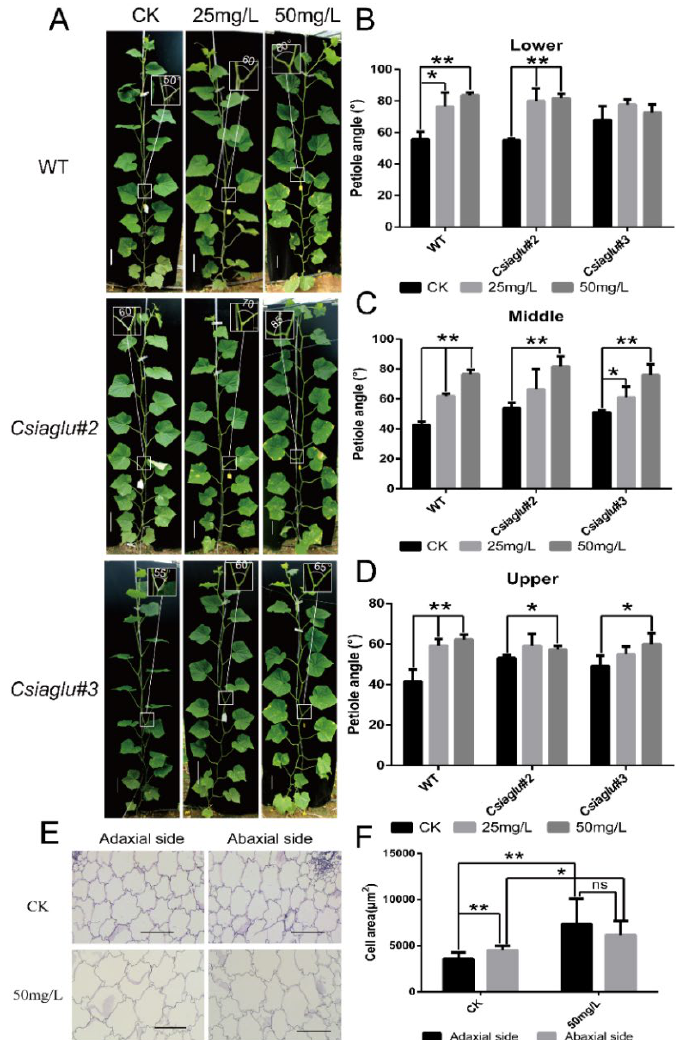
Figure 5. IAA treatment resulted in increased LPA in cucumber: ( A ) Representative images of WT and Csiaglu mutant plants following auxin application. The white boxes indicate the LPA of the largest leaf. Scale bars represent 10 cm. ( B - D ) Statistical analysis of LPAs of WT and Csiaglu mutants: lower LPAs ( B ), middle LPAs ( C ) and upper LPAs ( D ). Values are means of LPAs from the same part of three independent plants. ( E ) Cell morphology of transverse section of petiole base in CK plants and plants treated with 50 mg/L IAA. Scale bar = 100 µ m. ( F ) Cell area statistics of petiole base in CK plants and plants treated with 50 mg/L IAA. A significance analysis was conducted with the two-tailed Student’s t -test (* p < 0.05 and ** p < 0.01). Values are means ± SDs ( n = 3 in ( B – D ); n = 9 in ( F